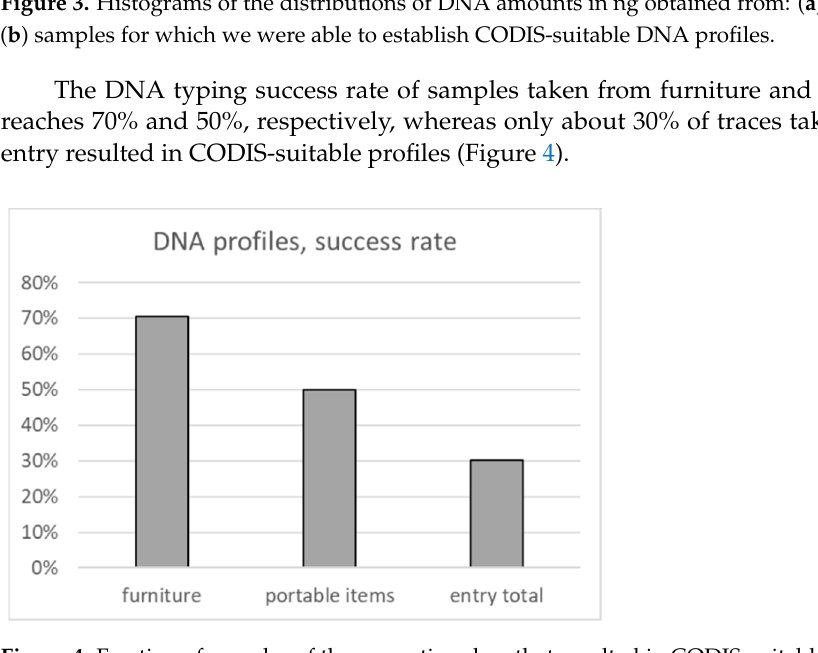
Figure 4. Fraction of samples of the respective class that resulted in CODIS-suitable DNA profiles.